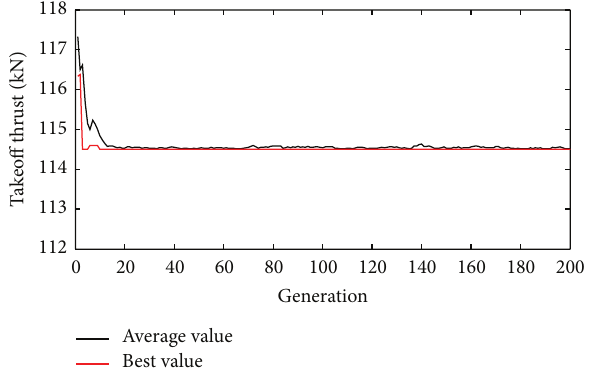
Figure 10: Best and average takeoff thrust (KN) versus